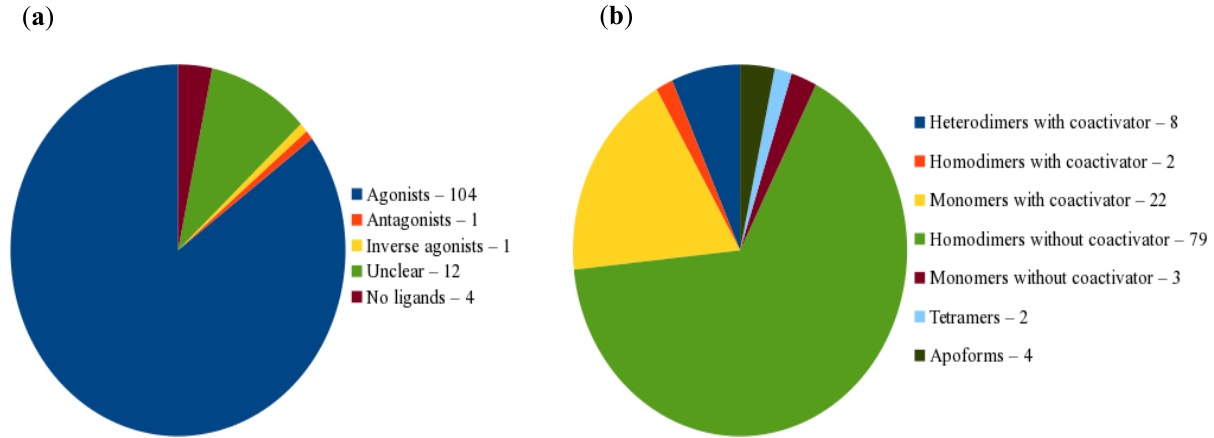
Figure 2. Distribution of the structures according to the type of: ( a ) the bound ligands; ( b ) the